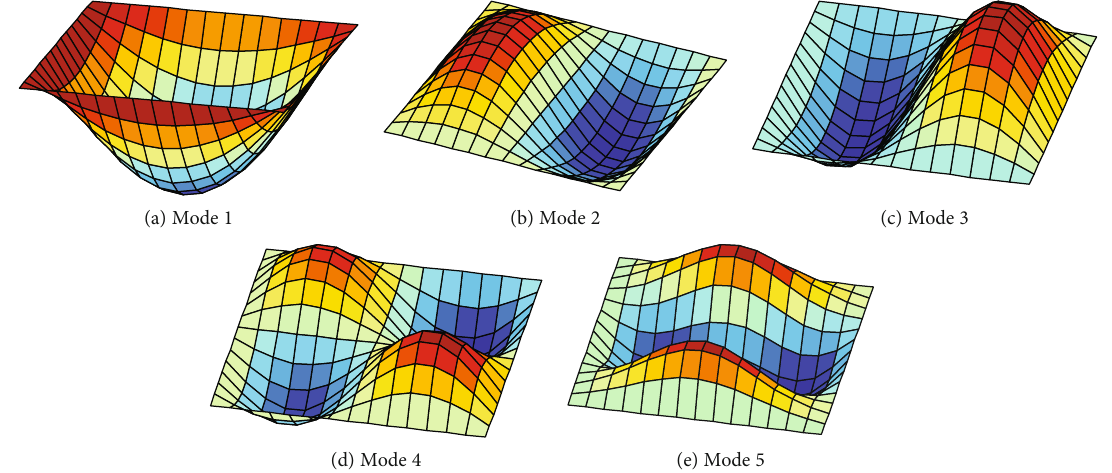
Figure 11: First fi ve fundamental vibration mode shapes, n = 10 , q = 1 , w